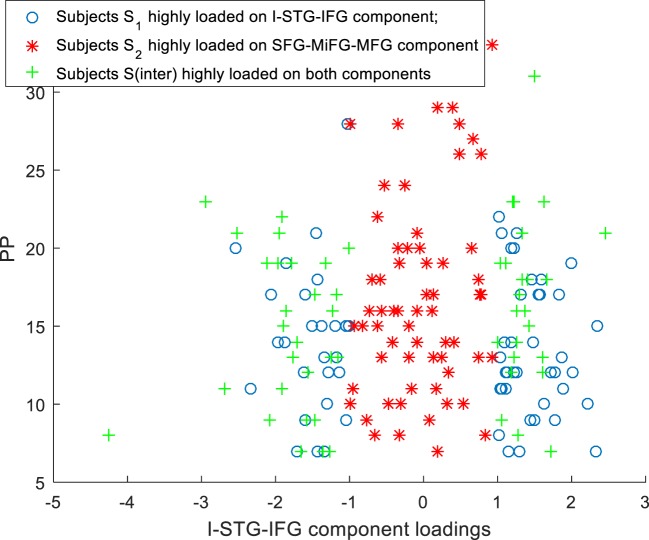
Scatter plots for subtypes S1, S2, Sinter I-STG-IFG component loadings Vs PP.